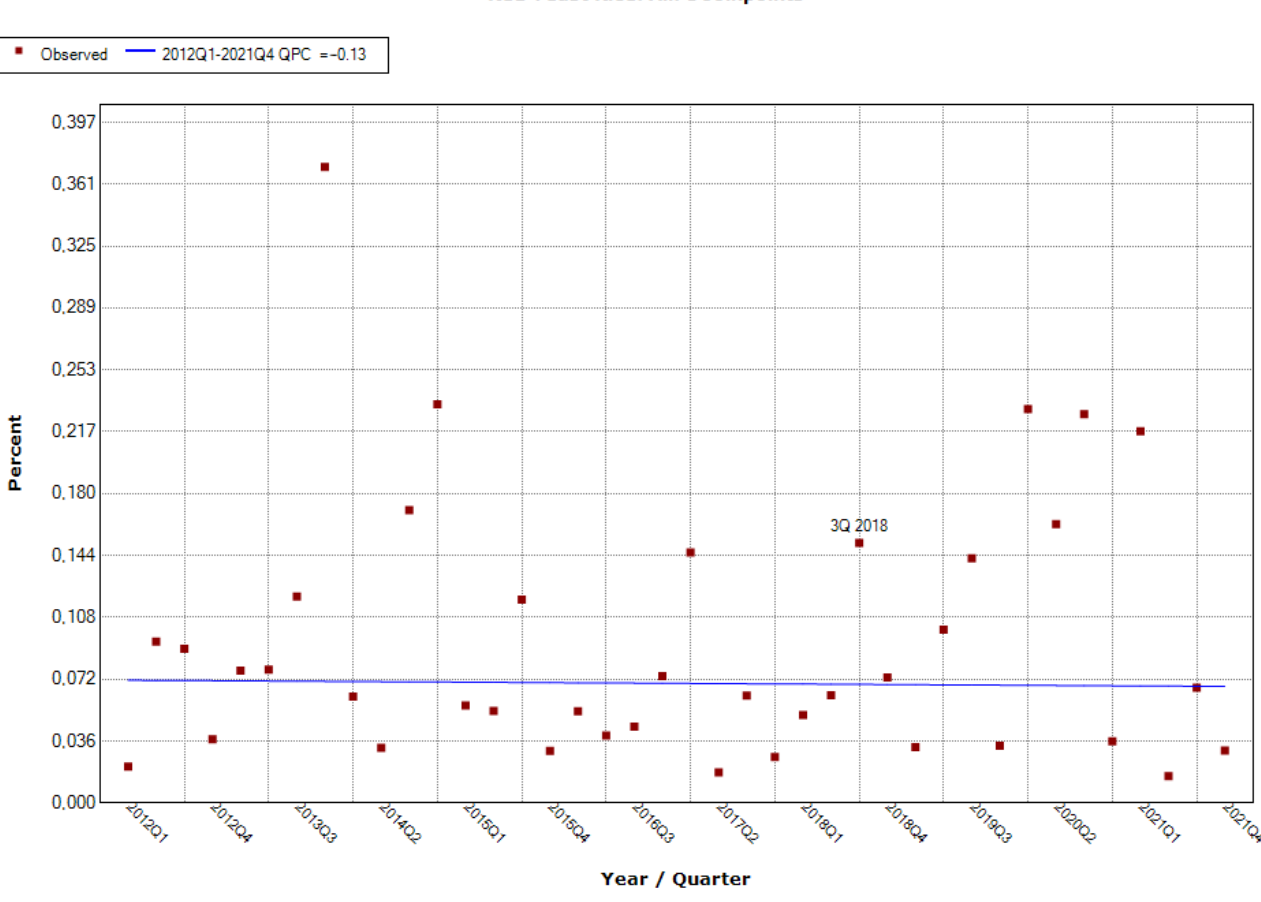
Figure A14. Percentage of products containing red yeast rice in individual quarters in the period from 2012 to 28 November 2021. Joinpoints mark trend turning points. The date above the observation indicates the moment of publication of the scientific opinion/resolution.